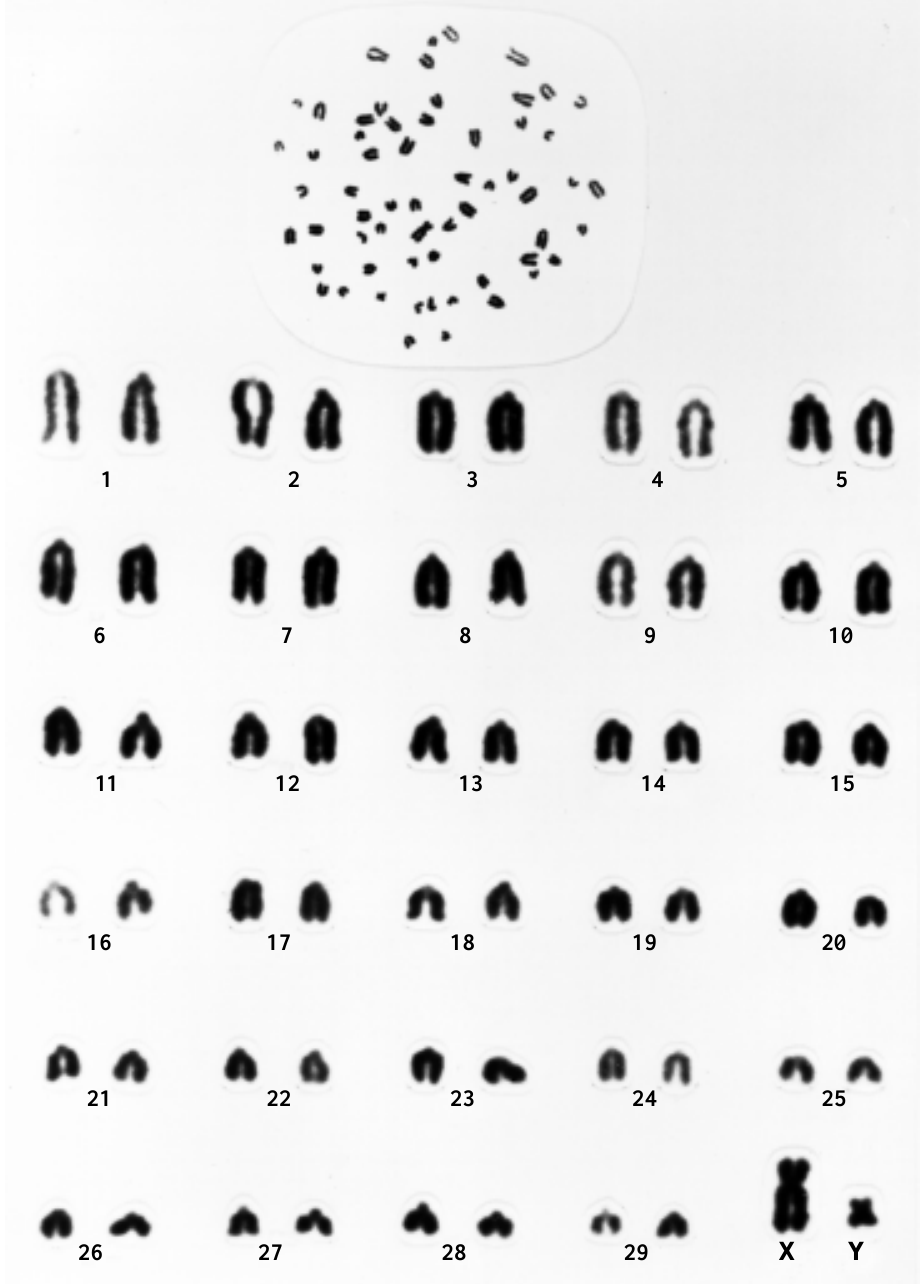
Figure 1 - Submetacentric Y chromosome-bearing karyotype of a “pé-duro” bull (2n = 60,